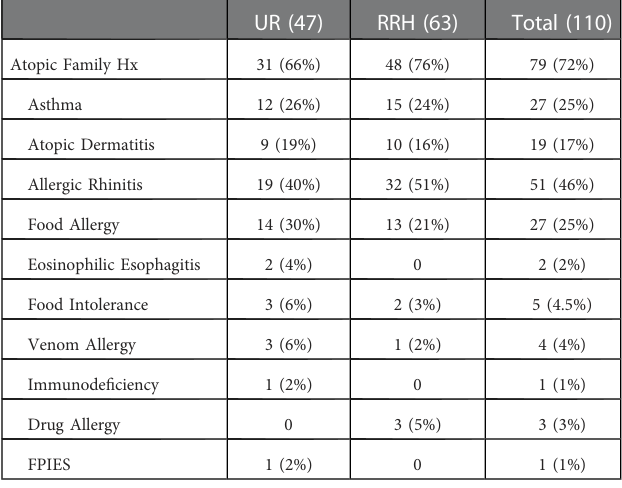
TABLE 2 Atopic family history in the FPIES cohorts . Family history is de fi ned as fi rst degree relatives. UR (47)